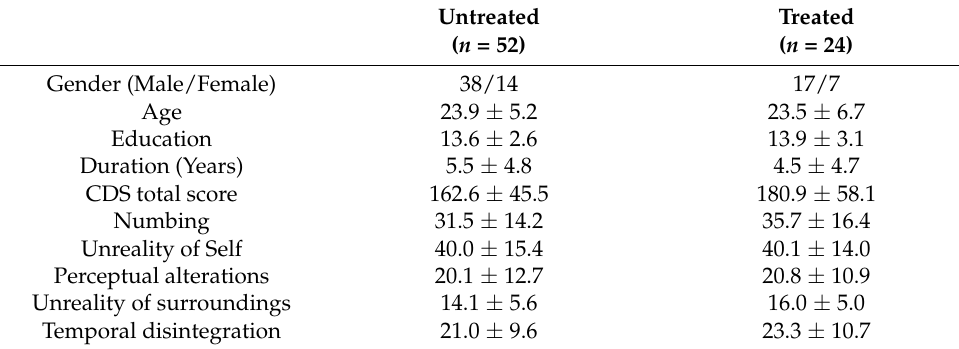
Table 2. Information on patients.